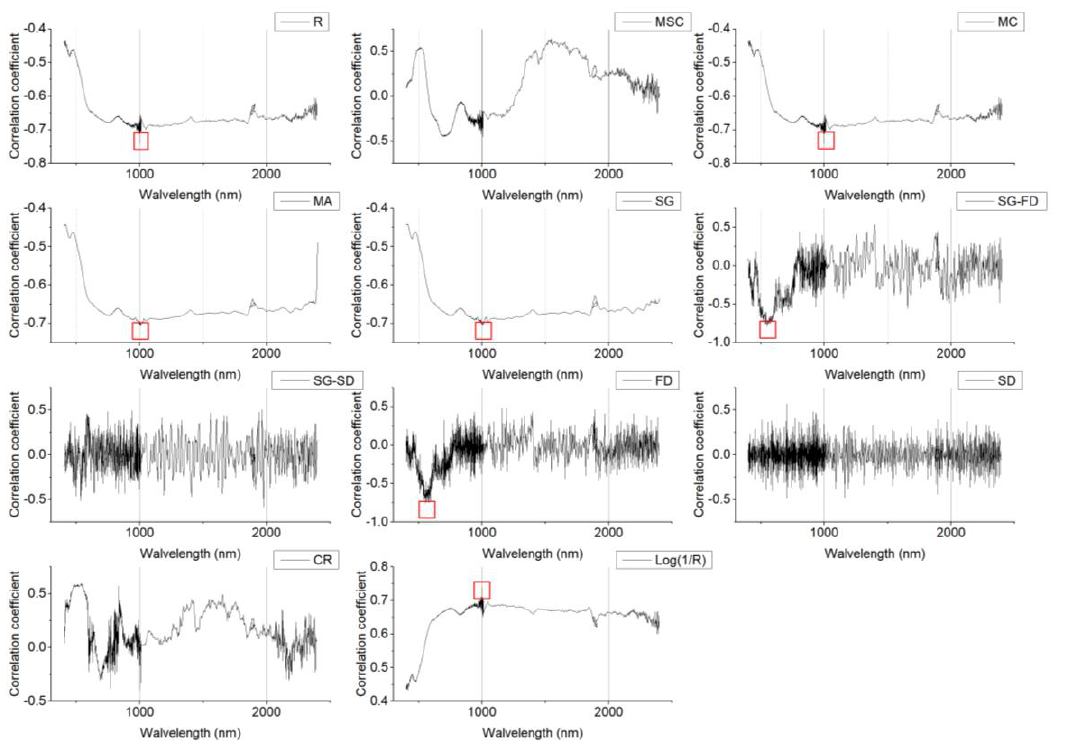
Figure 6. Changes in the SOM content and correlation coe ffi cients represented using di ff erent spectral indices (Honghu area).